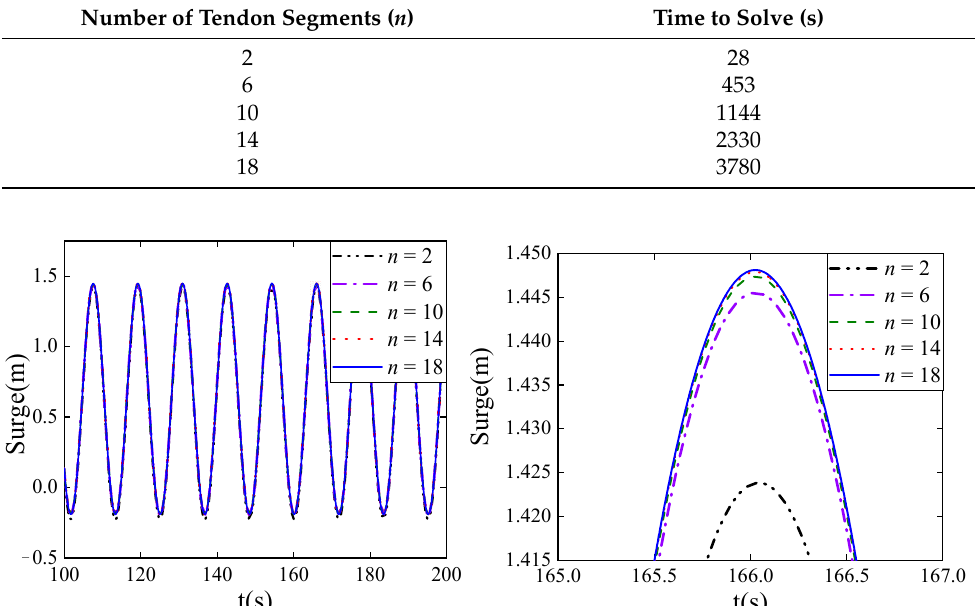
Table 2. Calculation time of DUTMST 2.0 with different numbers of tendon segments. Number of Tendon Segments ( n )